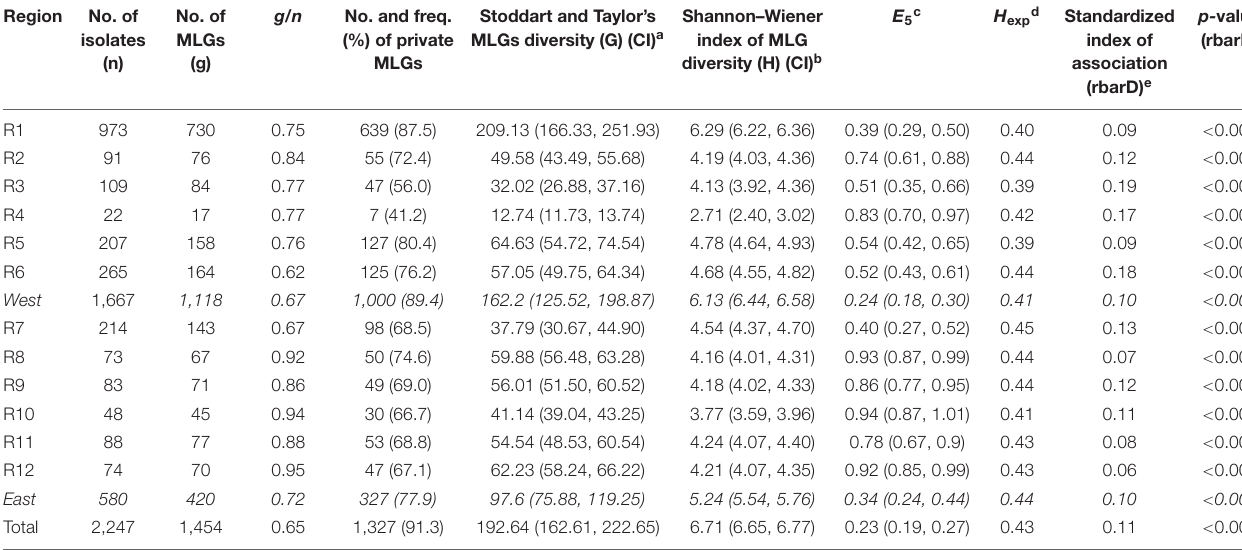
TABLE 2 | Numbers of Puccinia striiformis f. sp. tritici isolates, numbers of multilocus genotypes (MLGs), numbers and frequencies (%) of private MLGs, g / n values, Stoddart and Taylor’s MLG diversity (G) values and confidence intervals (CIs), Shannon–Wiener index values of MLG diversity (H) and confident intervals (CIs),